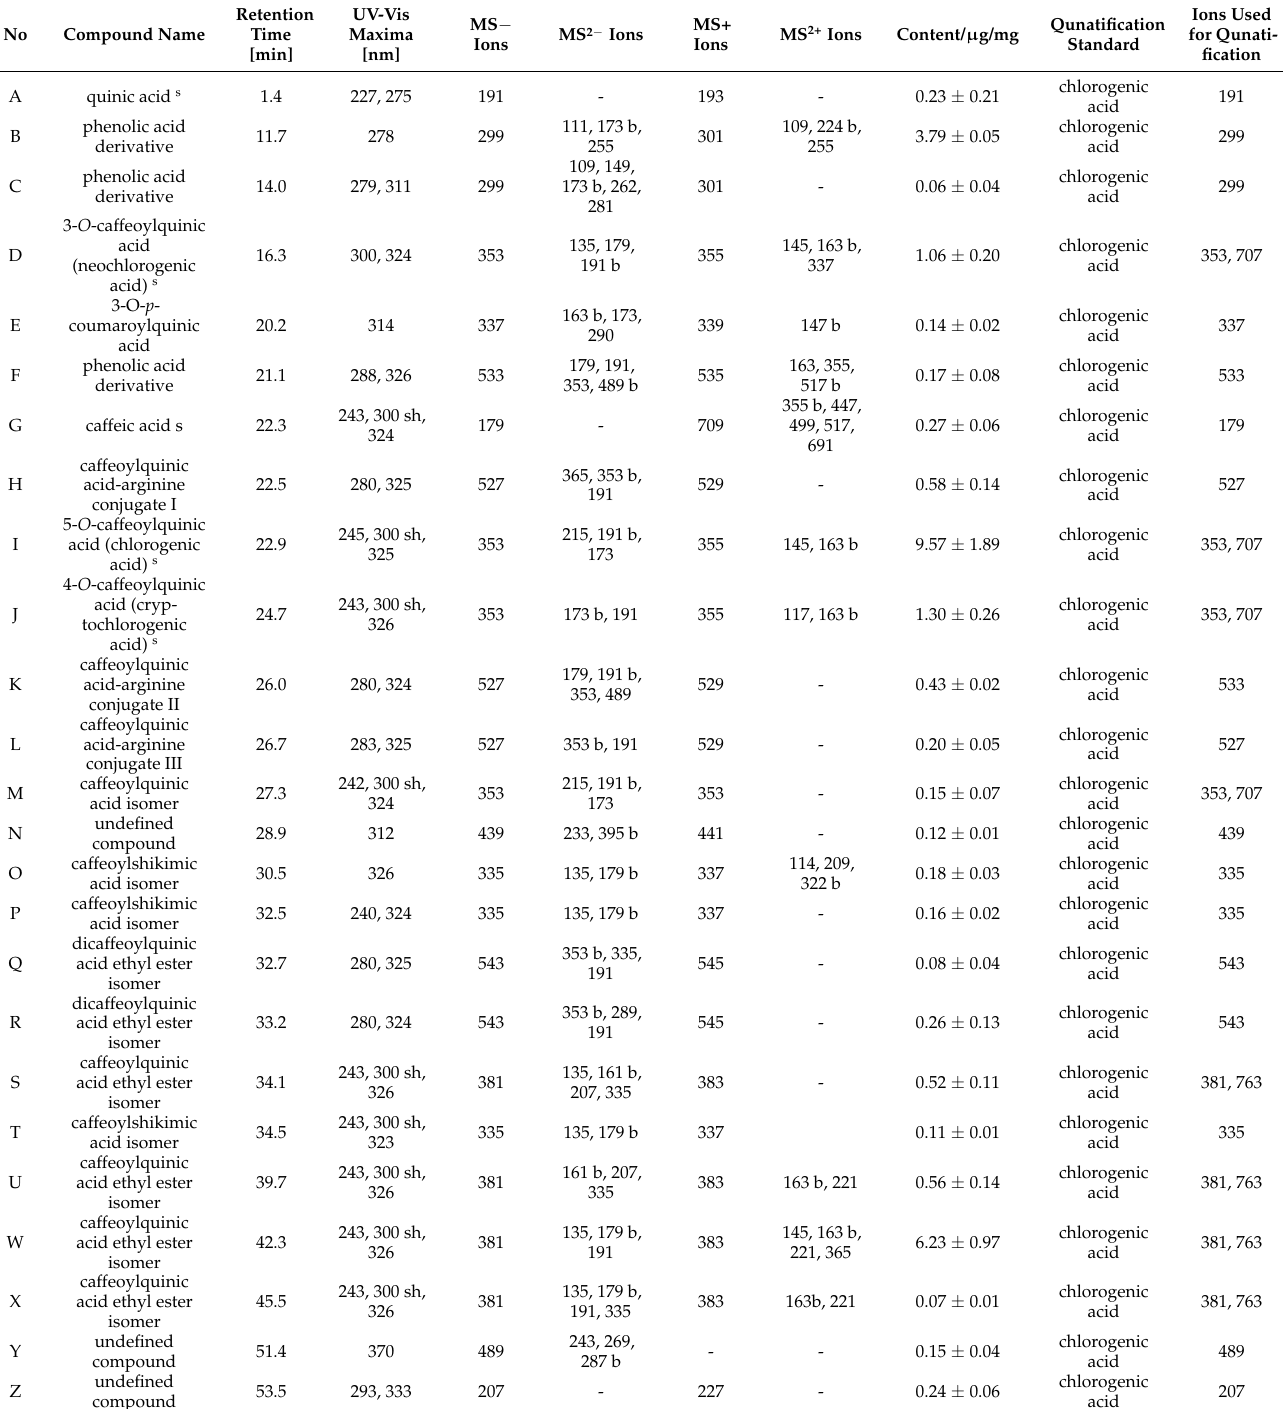
Table 2. Chemical composition of extract conjugated with arginie (E2) and quantification of major compounds using